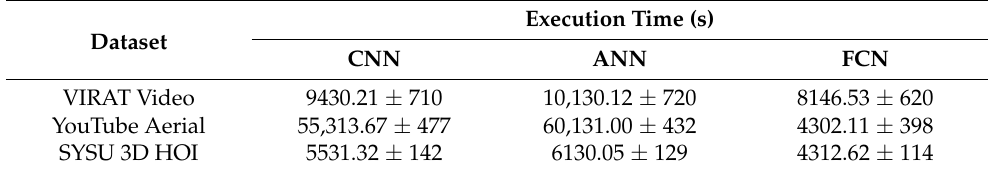
Table 10. Time complexity of different classifiers.